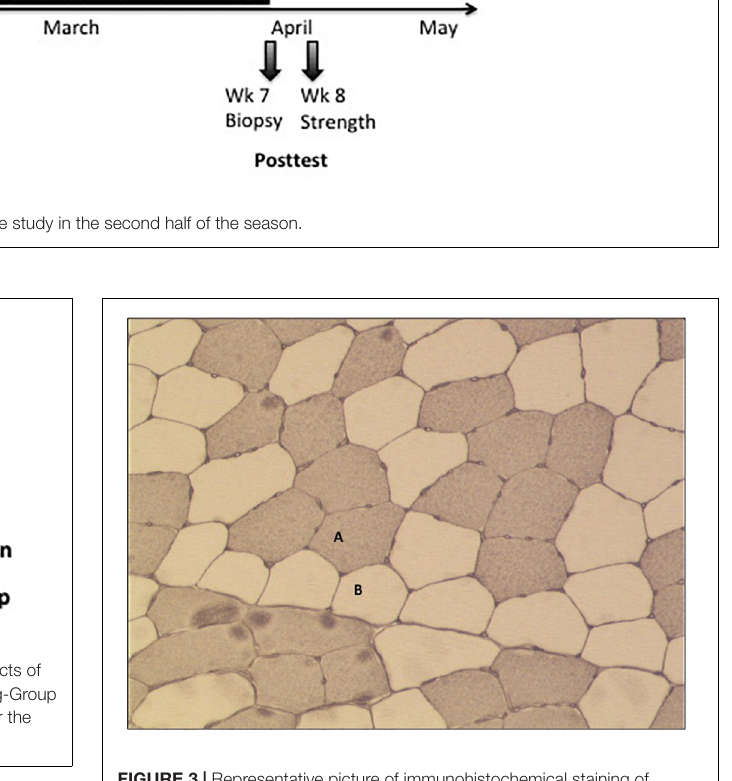
FIGURE 3 | Representative picture of immunohistochemical staining of myofiber cross-sections (10 × fold magnification). (A) Type I fibers (stained) and (B) type II fibers (no